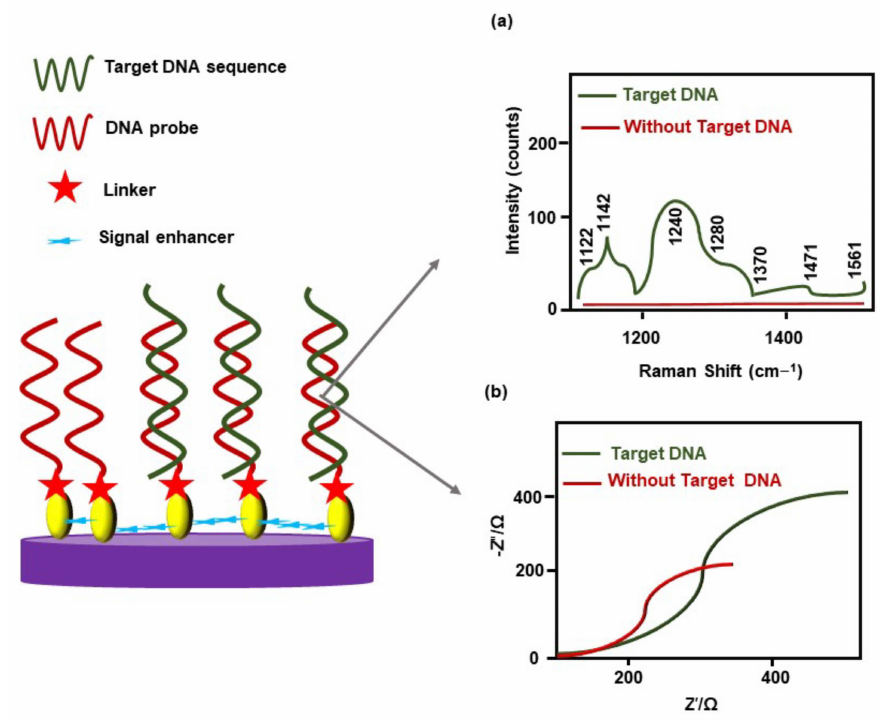
Figure 6. Detection of genetic changes in leukemia using AuNPs. Interaction with the target DNA sequence with the probe DNA cause changes in Raman spectra ( a ) and electrochemical signal ( b ). Signal-enhancer molecules accelerate signal changes upon binding of target nucleic-acid moiety, thereby making changes more visible and distinguishable. These images indicate potential results, but they do not reflect any actual